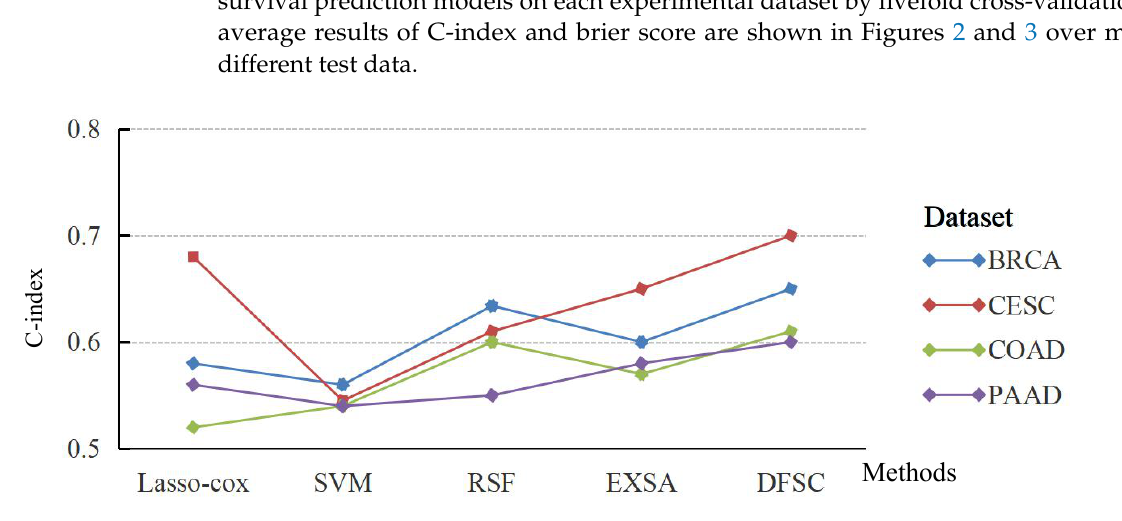
Figure 2. Average C-index achieved by learning model (higher is better) over multiple different train/test splits of each dataset.